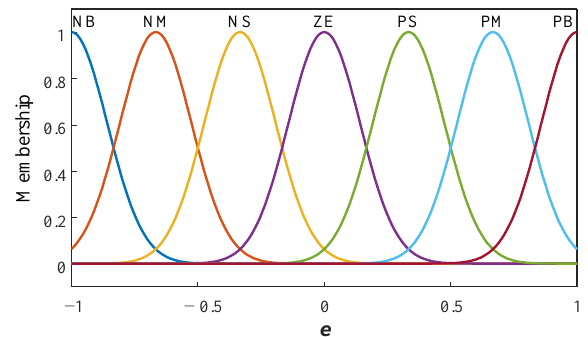
Figure 11. Gaussian membership function.